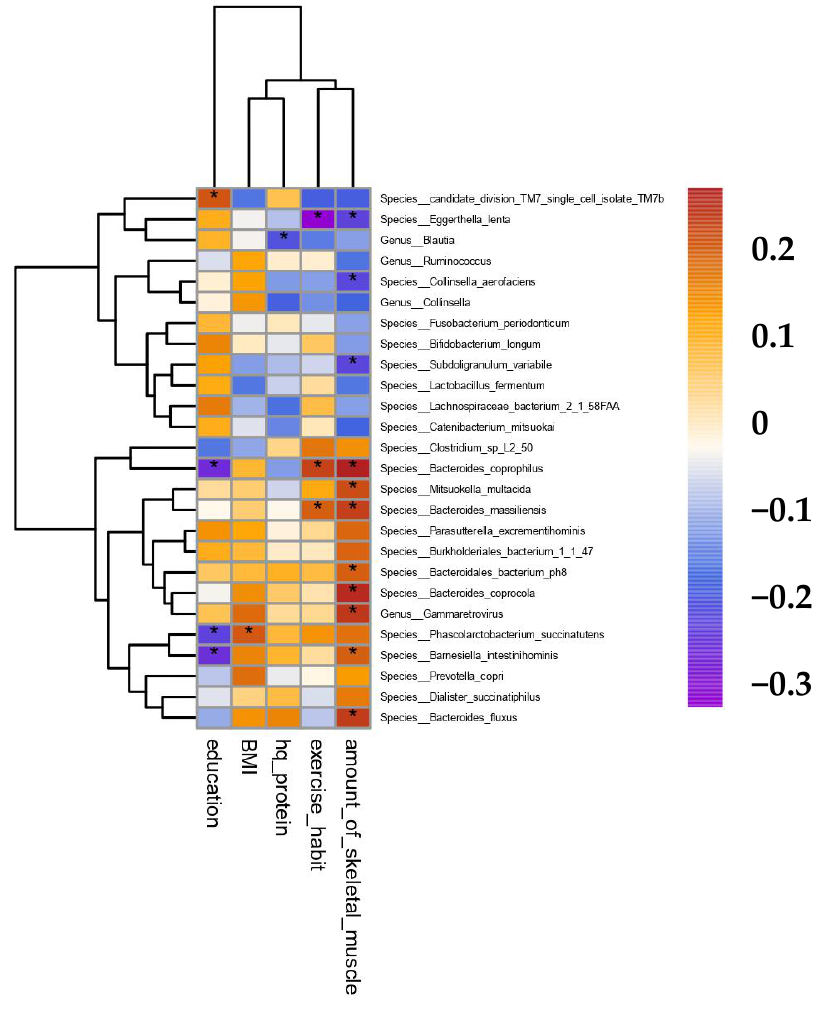
Figure 5. Spearman’s correlation heatmap. * indicates p < 0.05. Table 5. Results of multiple linear analyses of bacterial